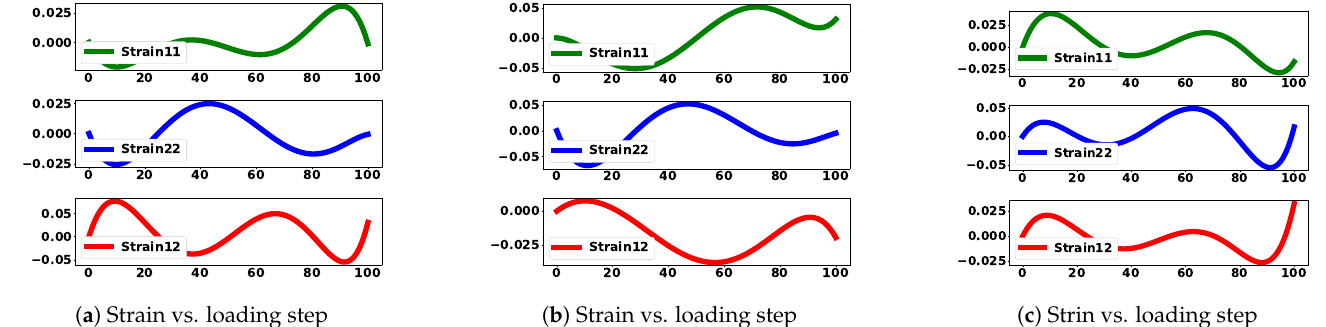
( a ) Strain vs. loading step ( b ) Strain vs. loading step ( c ) Strin vs. loading step Figure 4. Six random numbers are generated for the loading step at 0, 20, 40, 60, 80, and 100. A six-degree polynomial fitted to these random numbers to smooth the generated path-using polynomial 100 data are generated ( X -axis is time step and Y -axis is